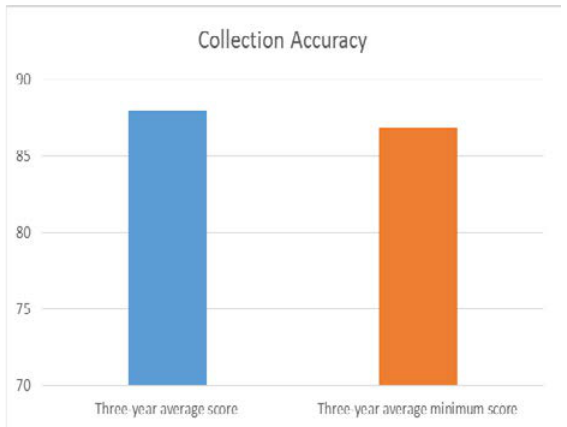
Figure3. Three-year average score and minimum score of collection accuracy